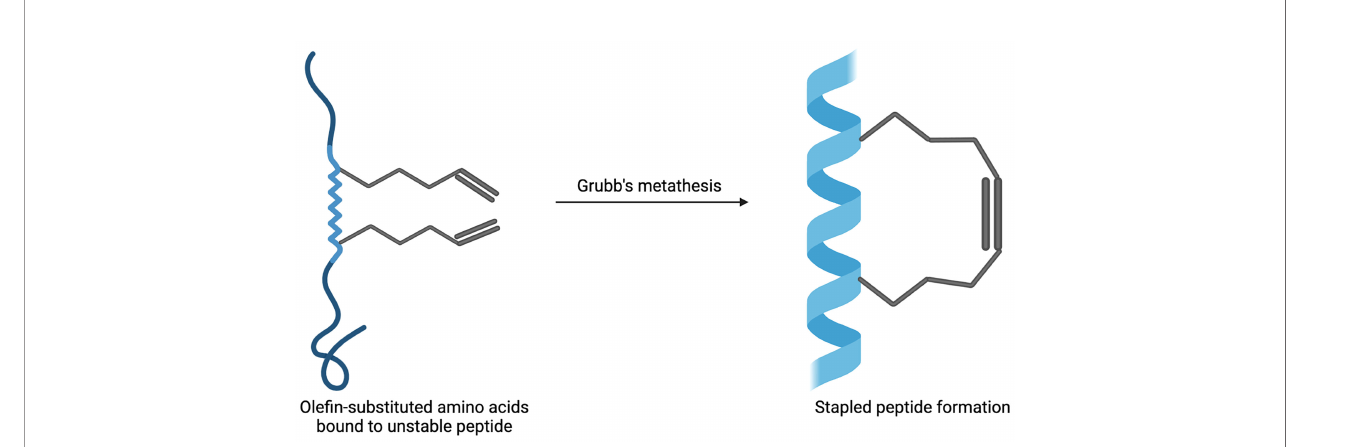
FIGURE 2 | Example of stapled peptide formation. Created with